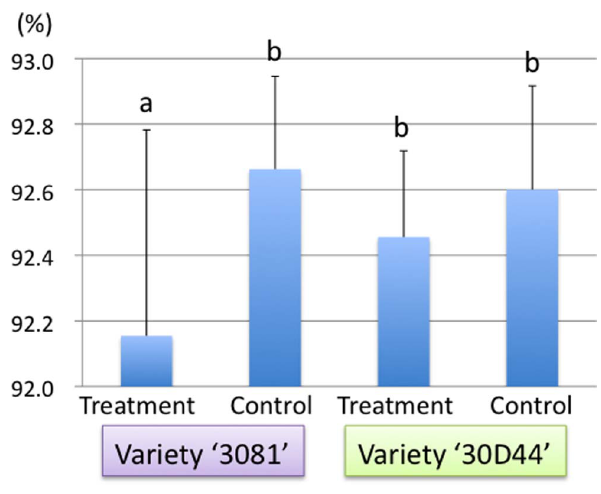
Figure 4. Water contents (%) of the third leaves of maize varieties ‘3081’ susceptible to C. bipunctata and ‘30D44’ resistant to C.bipunctata .